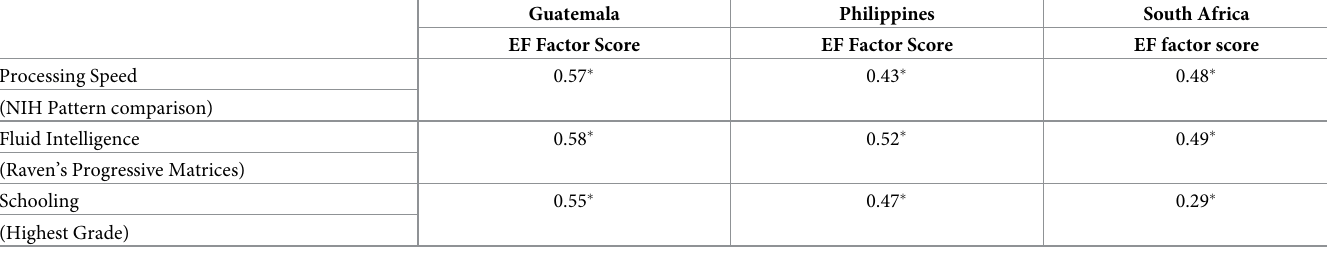
Table 4. Correlation between each country’s Executive Function (EF) factor scores and other cognitive measures and schooling.